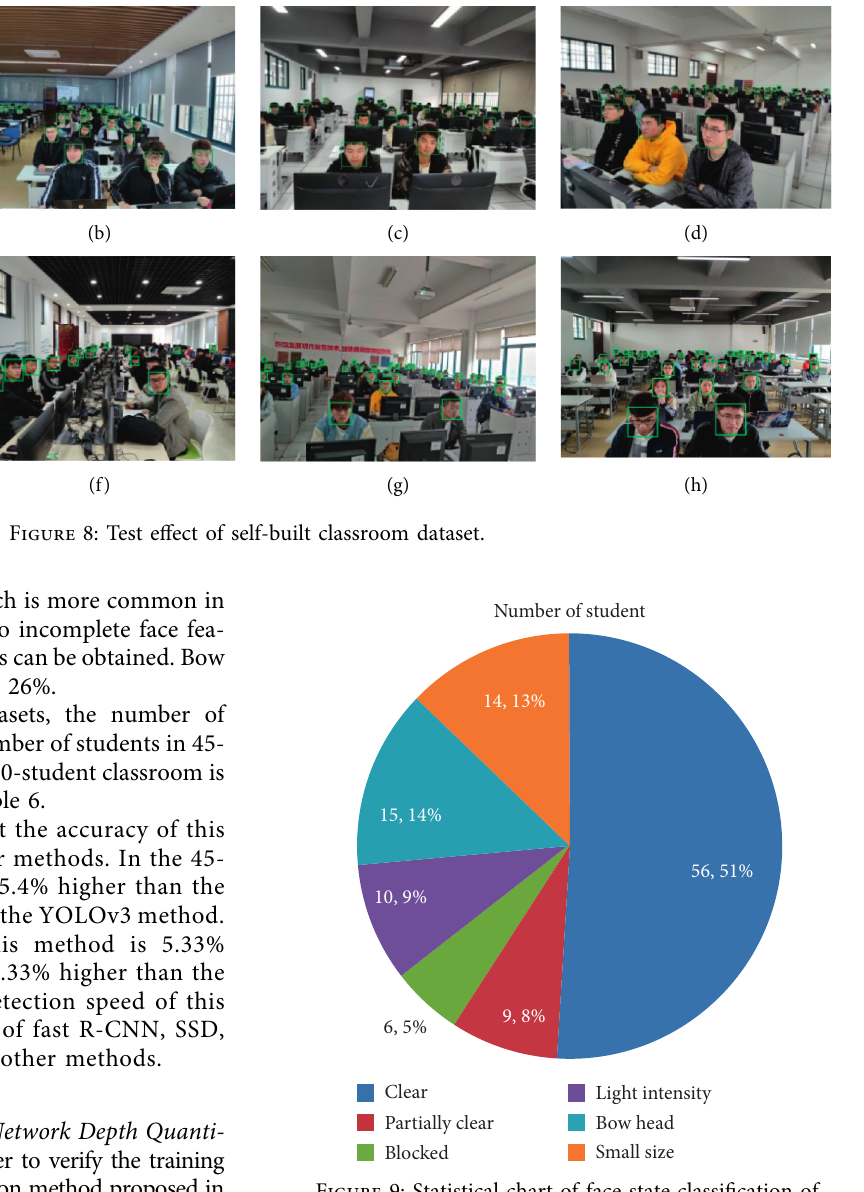
Figure 9: Statistical chart of face state classification